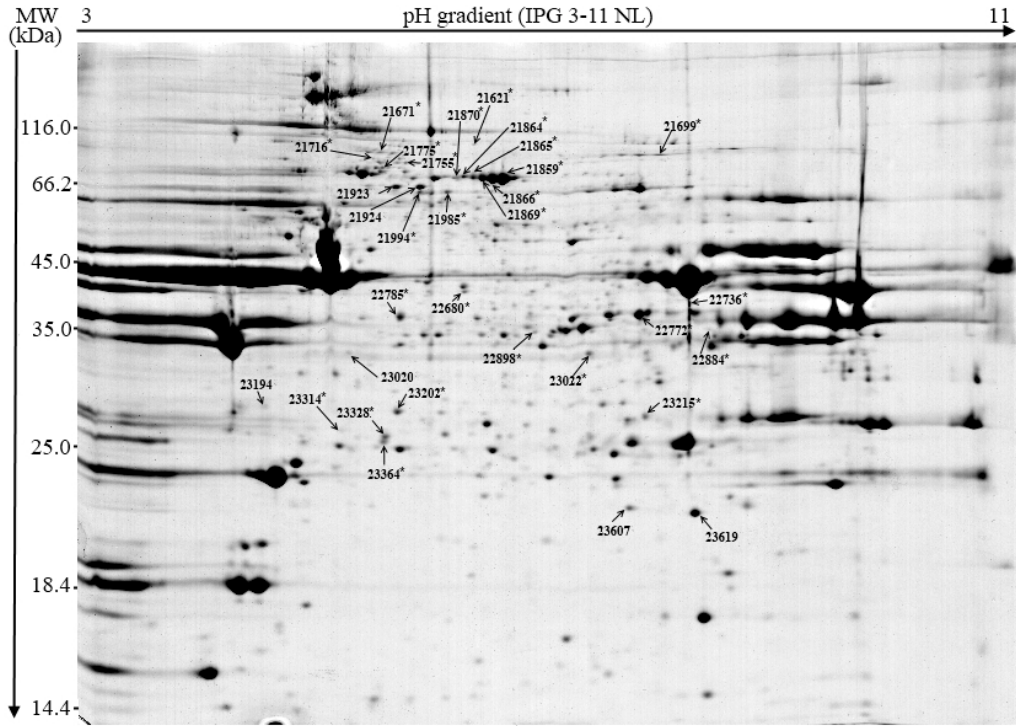
Figure 2. Two-dimensional electrophoresis gel image of the porcine longissimus lumborum muscle. The spots indicated by the arrows and identification (ID) number were identified by mass spectrometry; * denotes higher relative abundancy in samples from entire males.